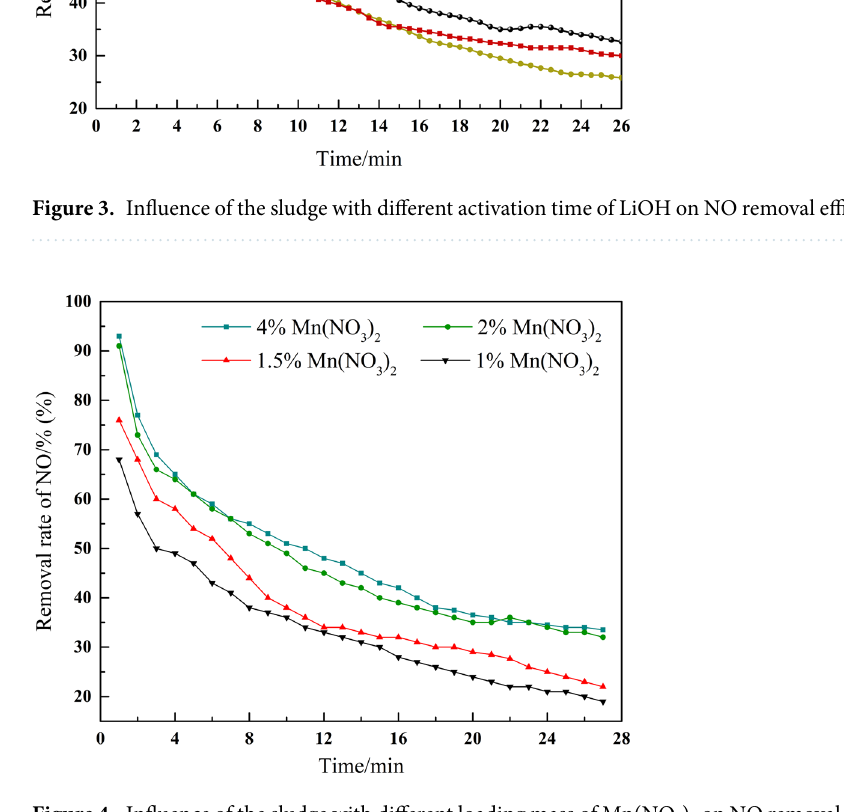
Figure 4. Influence of the sludge with different loading mass of Mn(NO 3 ) 2 on NO removal